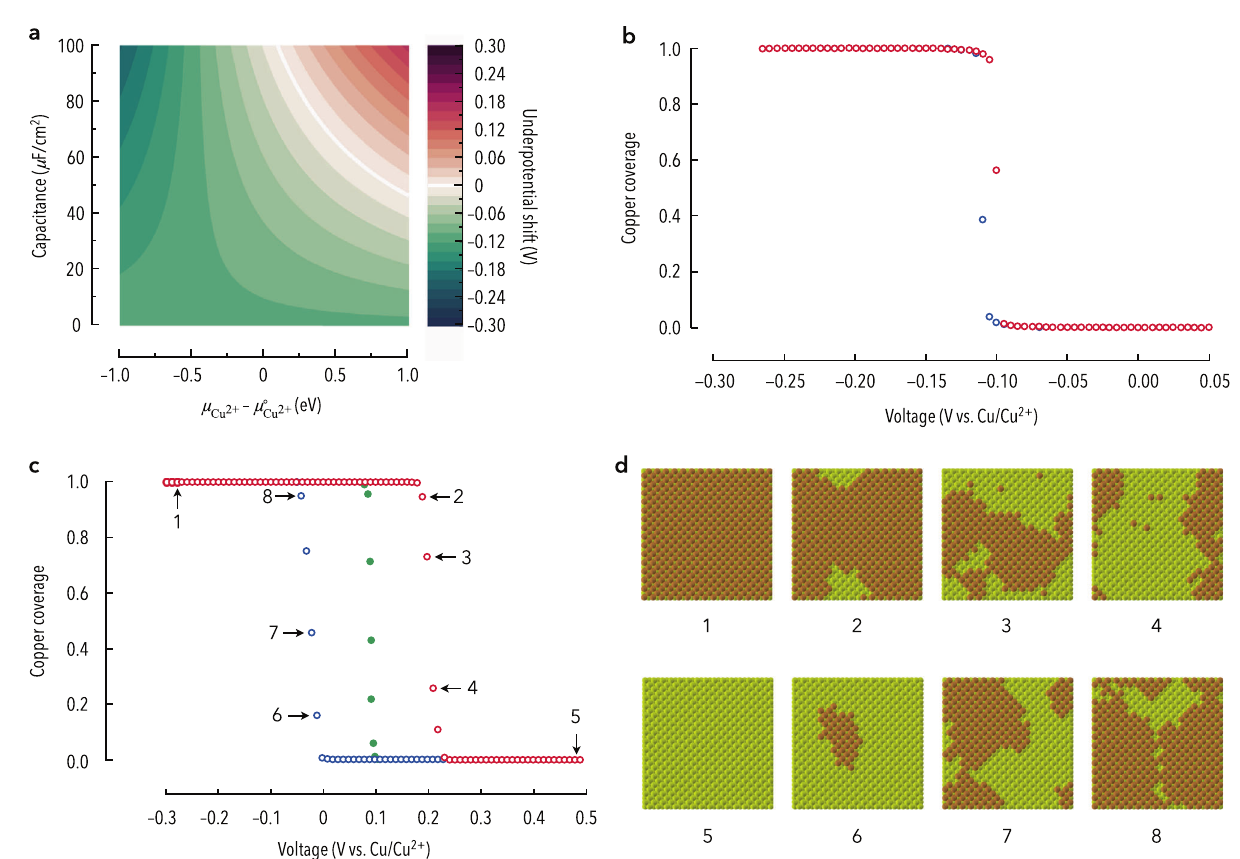
Fig. 3 Electrochemical Monte Carlo results for copper UPD on the gold (100) surface. a The computed underpotential shift for a half-covered gold (100) surface becomes more positive with increasing double layer capacitance and copper ion chemical potential. b The adsorption isotherm of the gold surface under vacuum conditions indicates the copper adlayer is stable up to − 0.11 V vs. Cu/Cu 2+ . c The adsorption isotherm of the gold surface with a capacitance of 80 μ F/cm 2 and a copper ion chemical potential 1 eV higher than the standard state. The red curve (labels 1 → 5) is for the run with an initially complete monolayer, and the blue curve (labels 5 → 8 → 1) is for the run with an initially pristine gold surface. The green curve shows the physical isotherm, when all surfaces are initialized with a random coverage of θ = 0.5. d Simulation snapshots along the cathodic and anodic voltage scans associated with the isotherm in panel